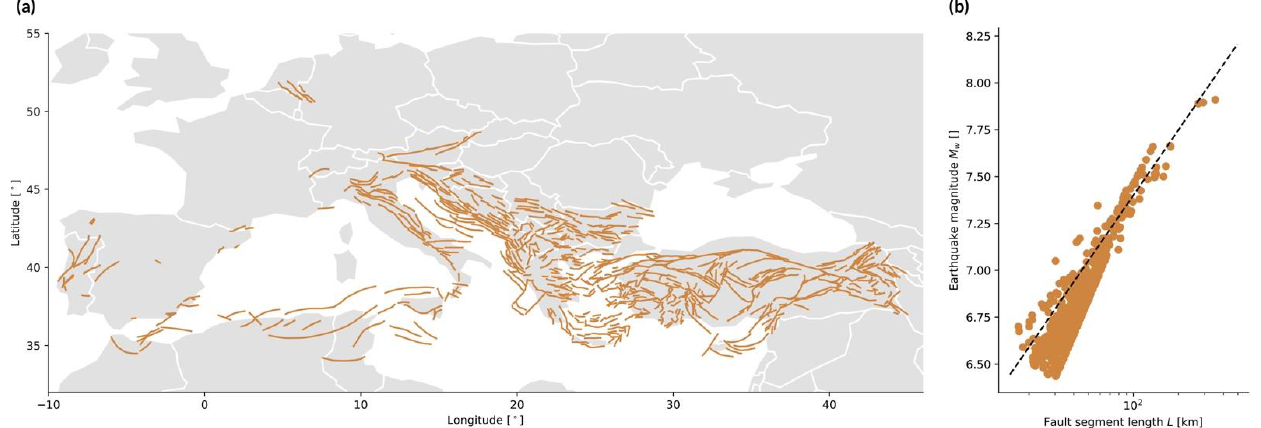
Figure 3. Example of line sources (earthquake case). ( a ) Fault segments in the 2013 European Seismic Hazard Model (ESHM13) [42]; ( b ) mean magnitude 𝑀 𝑤 versus effective fault segment length 𝑙 in the ESHM13, compared to Equation (8) (dashed line) with 𝑐 1 = 5.08 and 𝑐 2 = 1.16 [66].